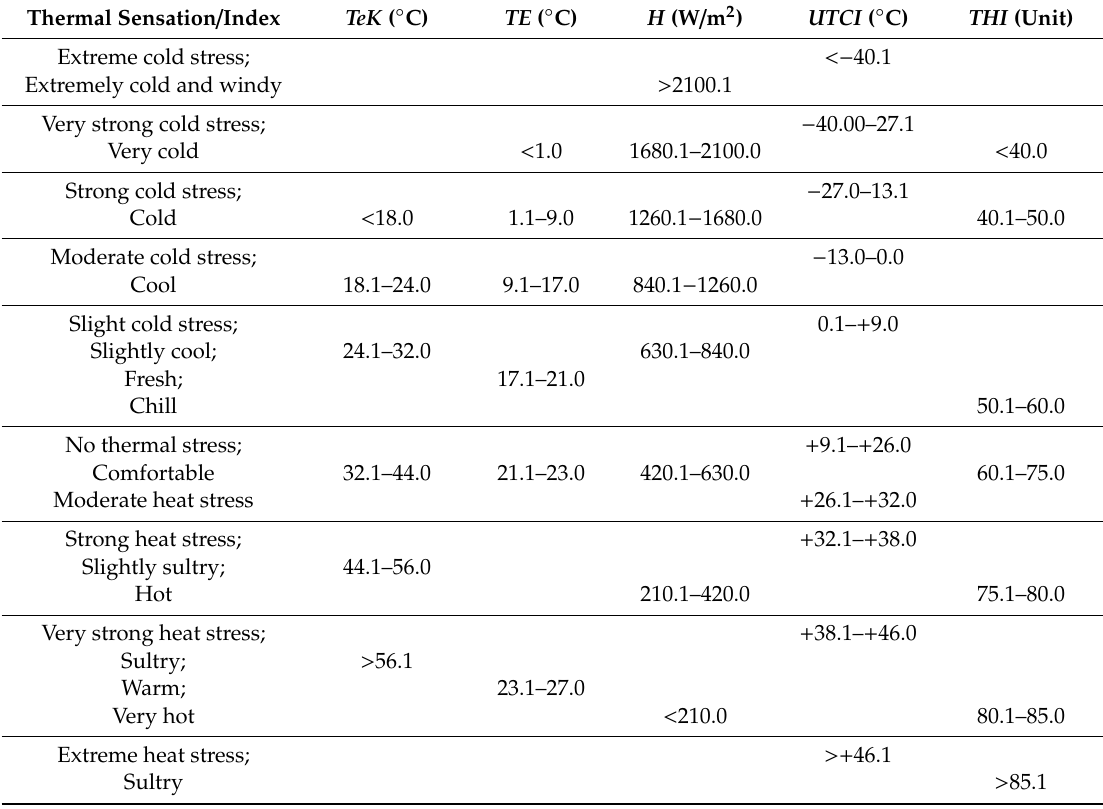
Table 2. Classes for thermal comfort and discomfort of the used